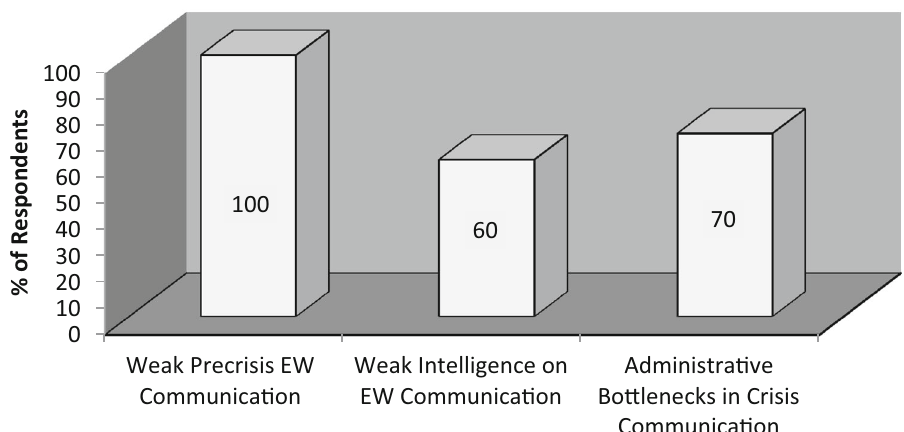
Fig. 4 Percentage